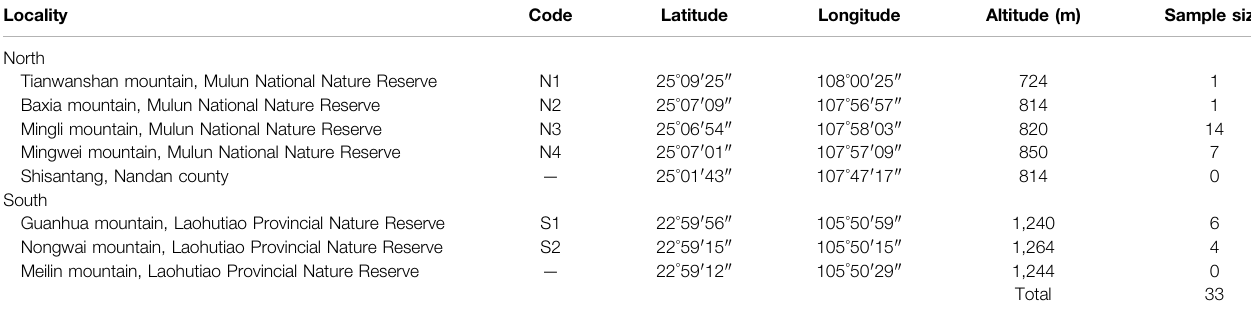
TABLE 1 | Distribution sites of Xanthocyparis vietnamensis in Guangxi, southwestern China. Locality Code Latitude Longitude Altitude (m) Sample size